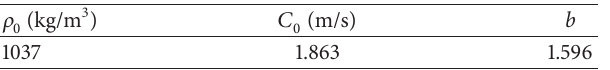
Table 6: Parameters in Murnaghan EOS for foam silicone rubber [26, 27].